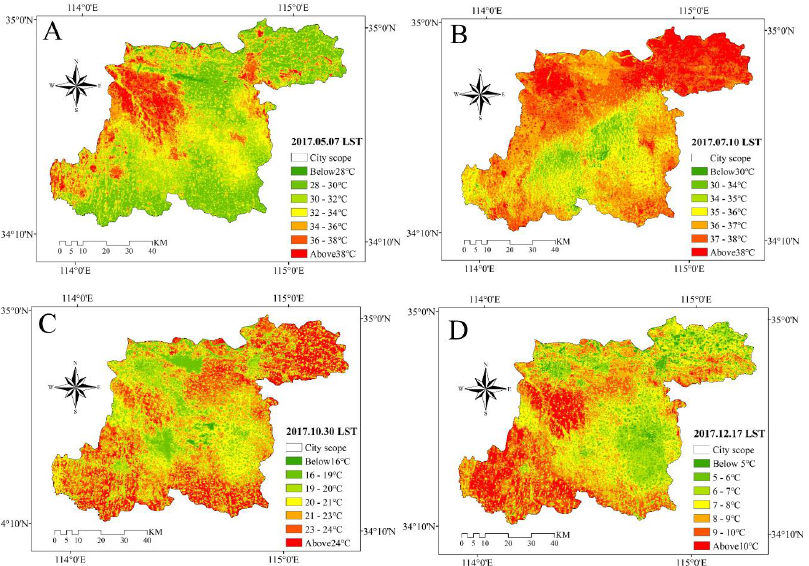
Figure 3. The inversion result of the surface temperature in Kaifeng. ( A ): 2017.05.07 LST distribution; ( B ): 2017.07.10 LST distribution; ( C ): 2017.10.30 LST distribution; ( D ): 2017.12.17 LST distribution.